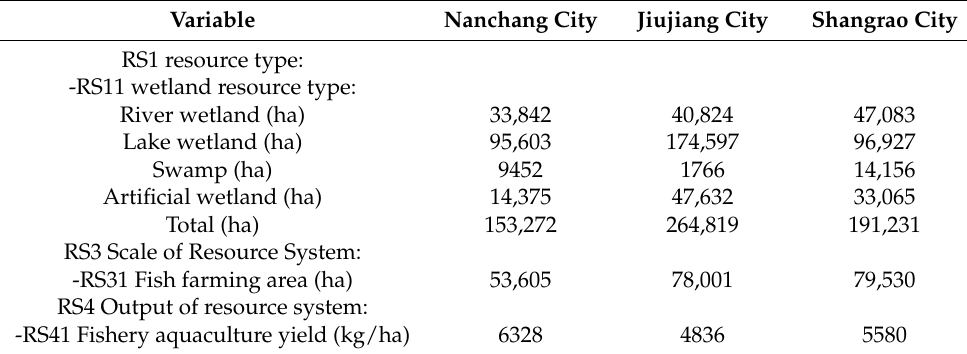
Table 4. Comparison of Poyang Lake wetland resource system